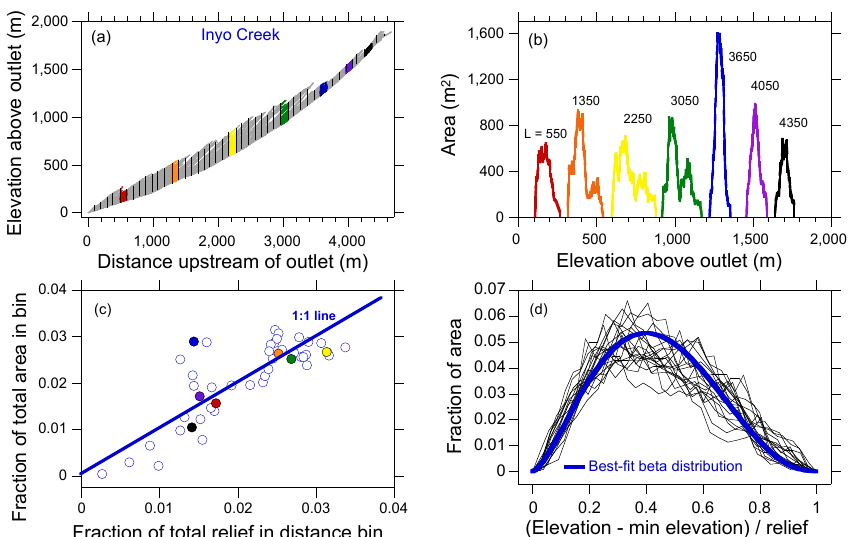
Figure 7. Elevation distributions for different travel distances at Inyo Creek. (a) Elevation data points for Inyo Creek catchment parsed into forty-seven 100m wide travel distance bins. (b) Distributions of elevation for seven representative travel distance bins; colors correspond to shaded bins in panel (a) , and mean travel distance is indicated for each curve. (c) Fraction of total area in each travel distance bin as a function of fraction of total relief in each bin, roughly follows the 1 : 1 line, colored symbols indicate representative bins in panels (a) and (b) . (d) Collapse of elevation distributions for each travel distance bin, with elevation normalized by relief within bin and area by total area within bin. Best-fit beta distribution captures typical shape of hypsometry for a given travel